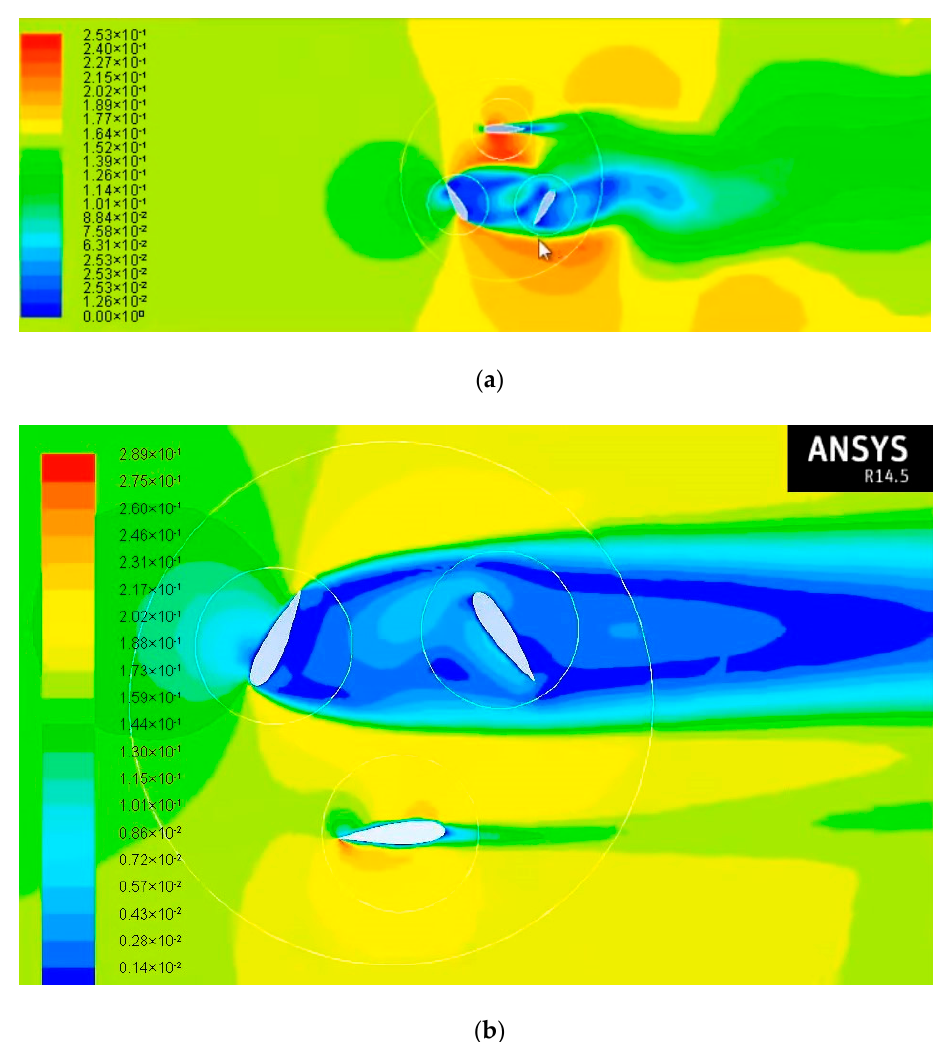
Figure 8. Results of the simulation (velocities): ( a ) simulation results and ( b ) enlarged view of the simulation model.